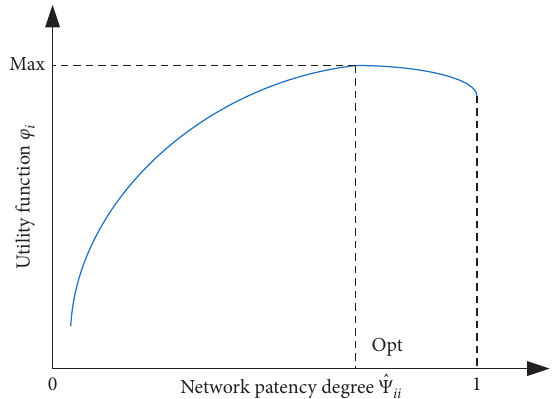
Figure 3: The relationship between utility function with penalty and network patency